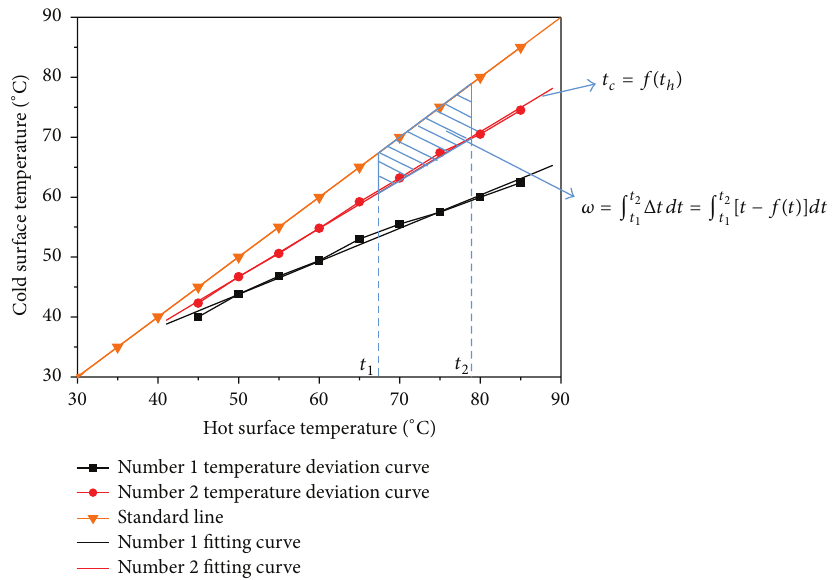
Figure 2: Cold surface temperature as a function of hot surface temperature for the paper cups. The area of the shaded part (the shape with the oblique lines) is 𝜔 .